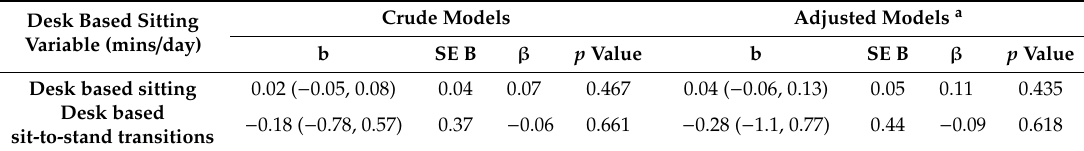
Table 2. Associations between desk-based sitting, desk-based sit-to-stand transitions and hair cortisol levels.